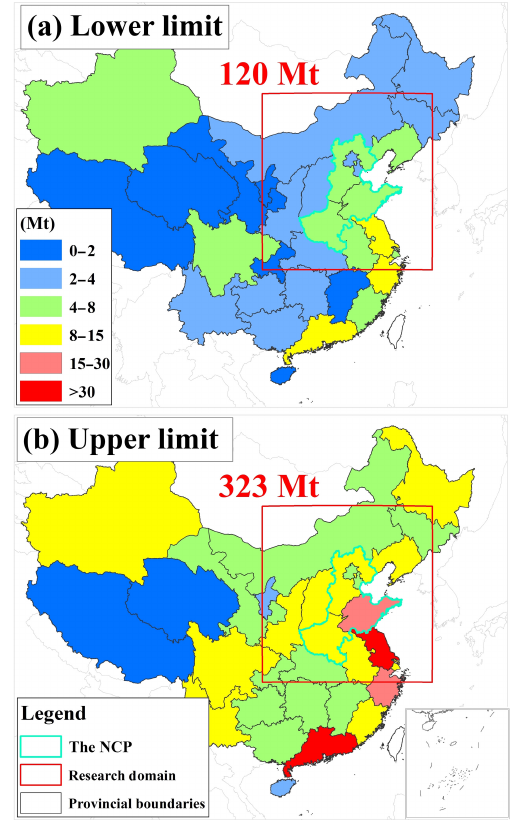
Figure 4. The (a) lower and (b) upper limits of potential coal sav- ings induced by the